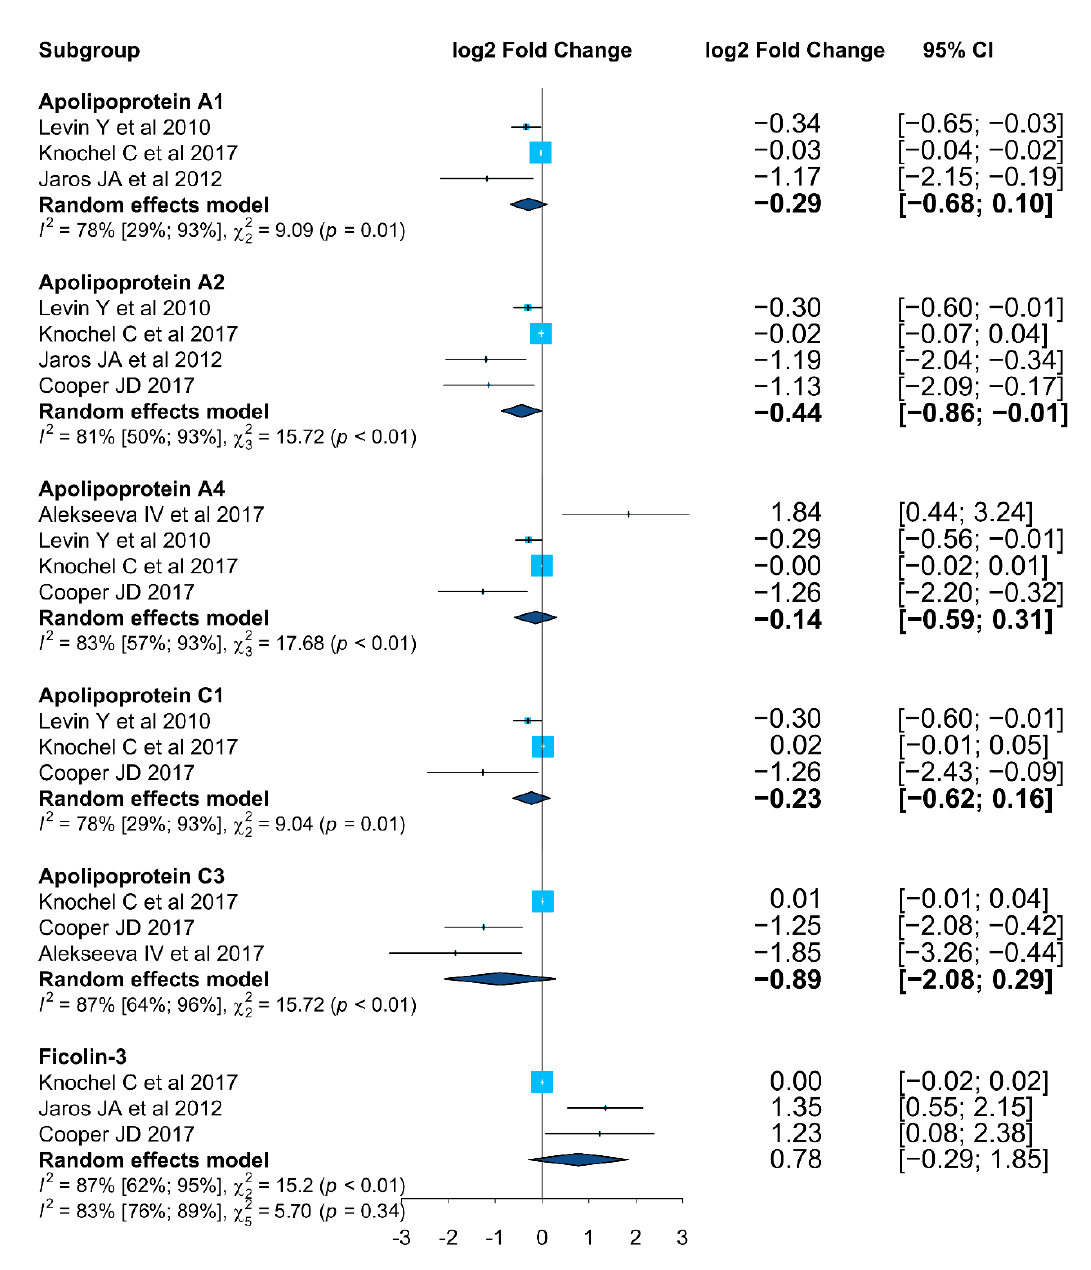
Figure 5. Forest plot from the meta-analysis of proteins identified as altered in SCZ vs. control studies in at least two studies (95% CI, confidence intervals). Squares (whiskers represent 95% CI) indicate the effect sizes of the individual studies. The size of the squares reflects the sample size of each individual study. Diamonds represent summary statistics.